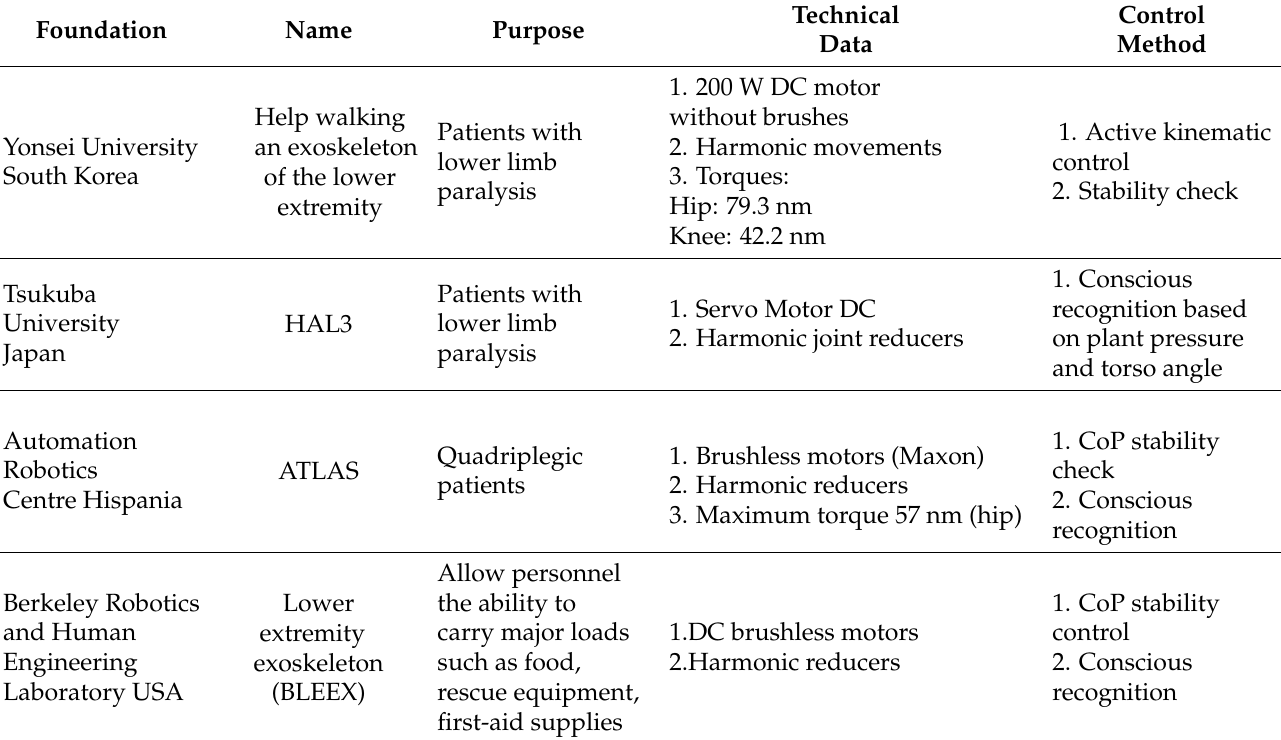
Table 2. Robotic exoskeletons around the